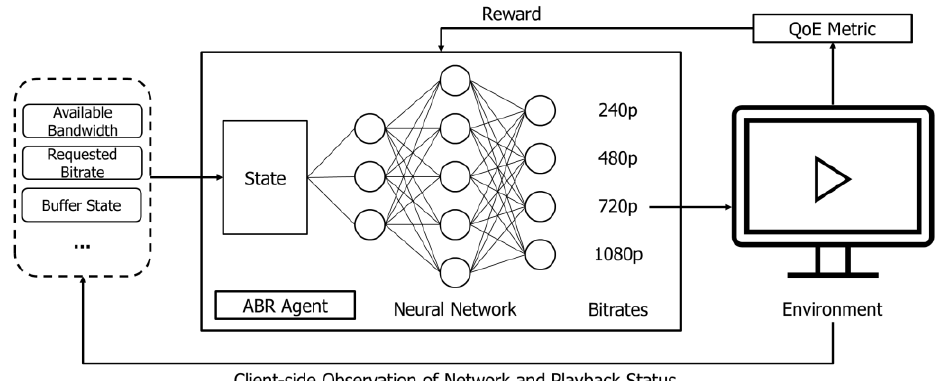
Figure 2. Adaptive streaming with reinforcement learning